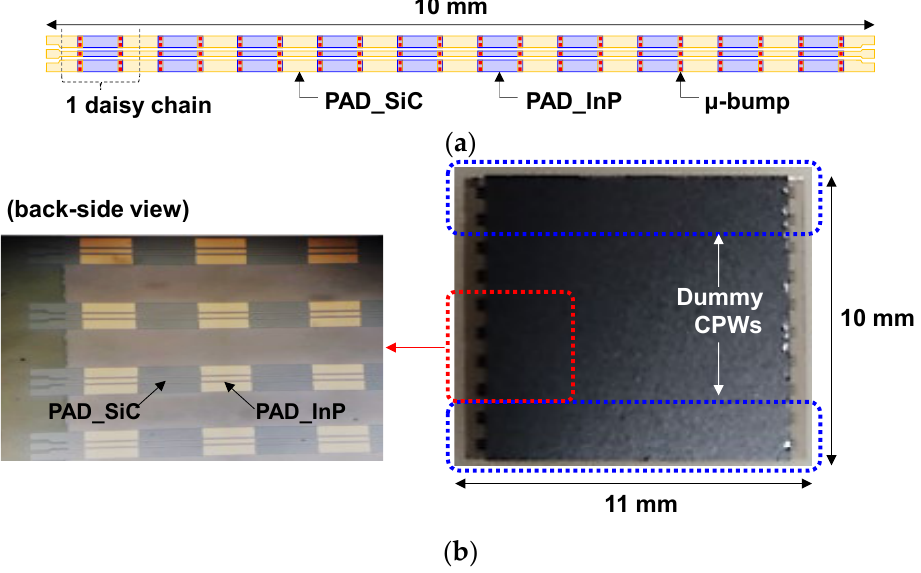
Figure 8. Implementation results of InP-to-SiC CPW lines with a hundred μ-bumps: ( a ) schematic diagram of a InP-to-SiC CPW line; ( b ) microscope images of a fabricated flip-chip-bonded sample with an area of 11 × 10 mm 2 arranged with ten CPW lines (six real and four dummy lines).